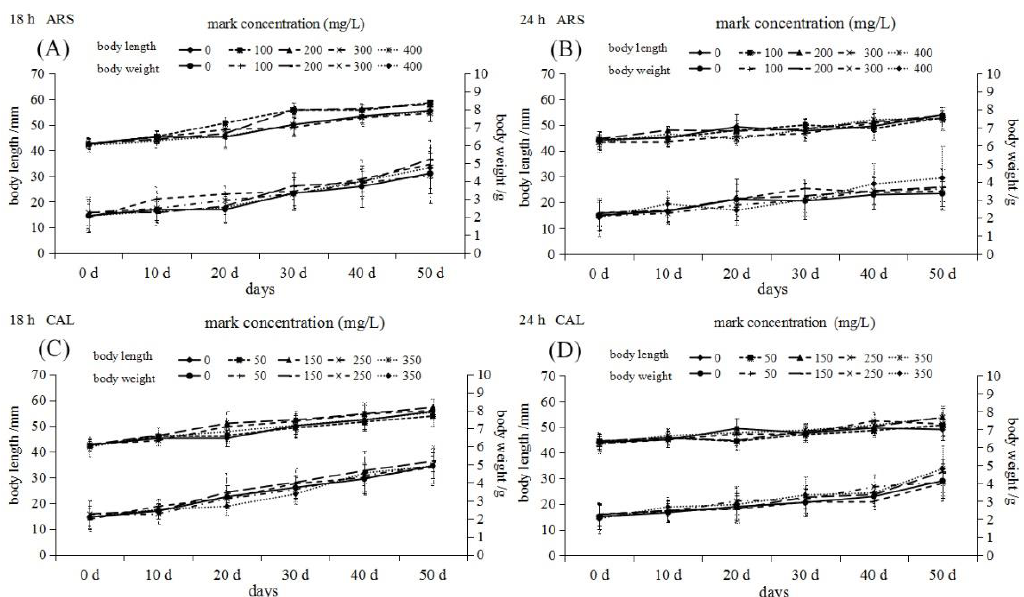
Figure 1. Mean body lengths and weights of black sea bream at different times after ARS ( A , B ) and CAL ( C , D ) marking treatment. Data were collected on the 0, 10th, 20th, 30th, 40th and 50th d of the growth experiment.